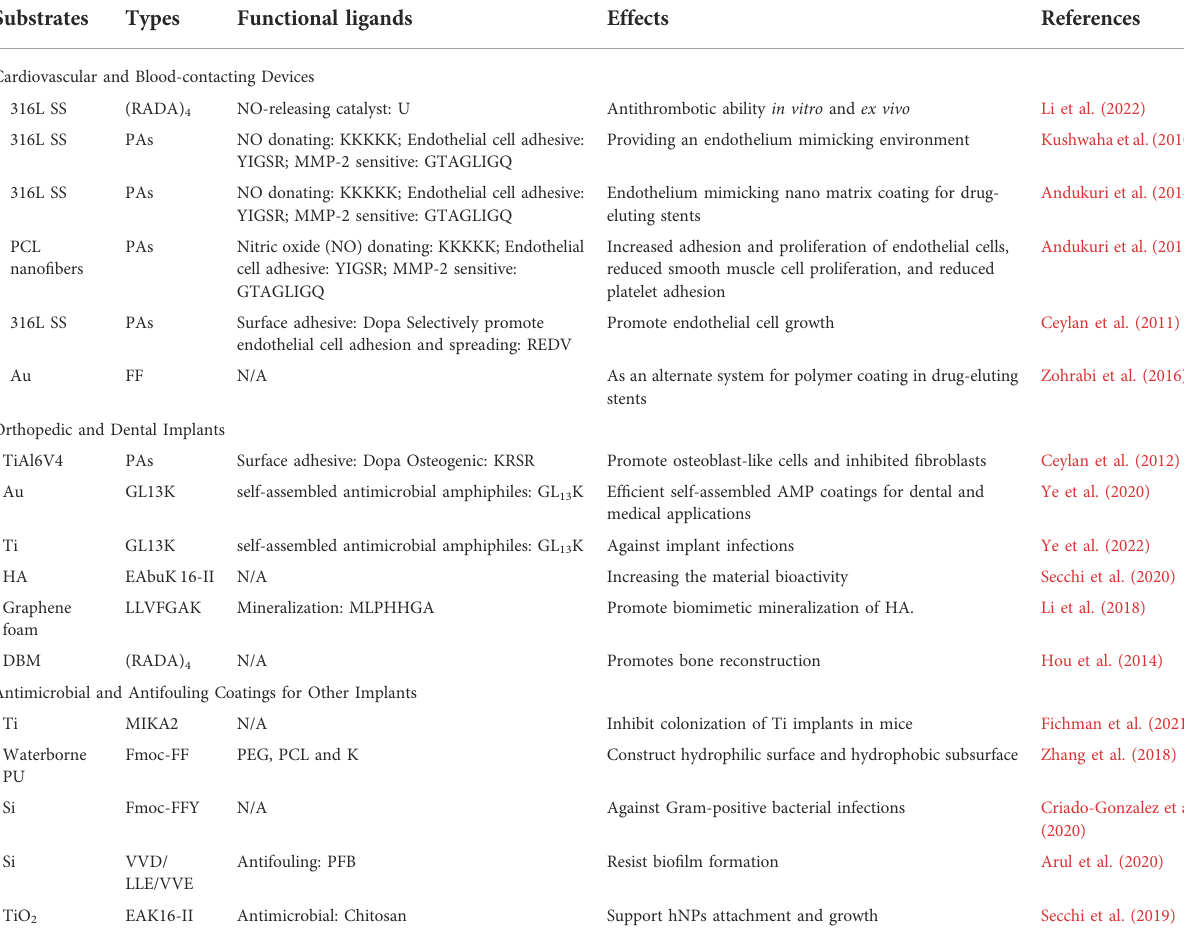
TABLE 1 Self-assembling peptide matrices as functional coatings for implantable